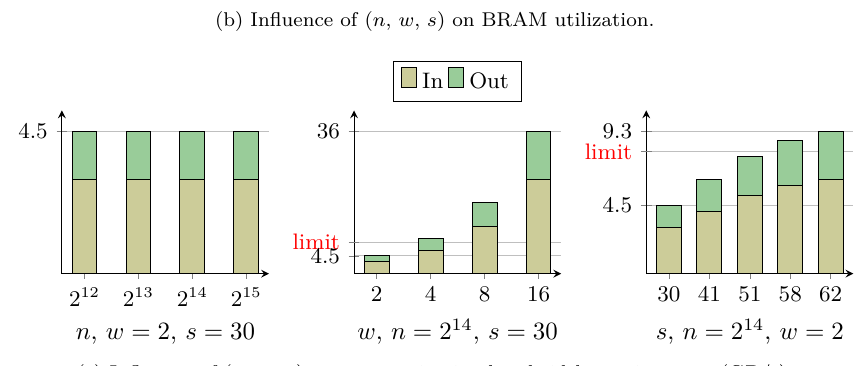
Figure 6: Estimation of resource utilization under the influence of sizing